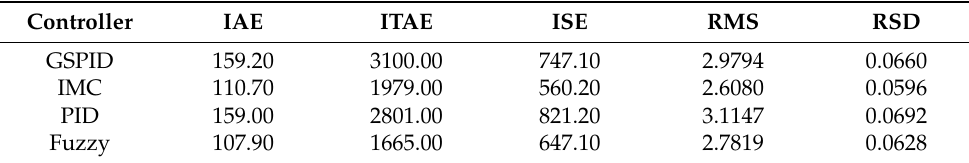
Figure 11. Random disturbance in the tank input flow (upper graph) and controllers’ response to Table 6. Performance indexes obtained considering a 90 s simulation this disturbance (lower graph).